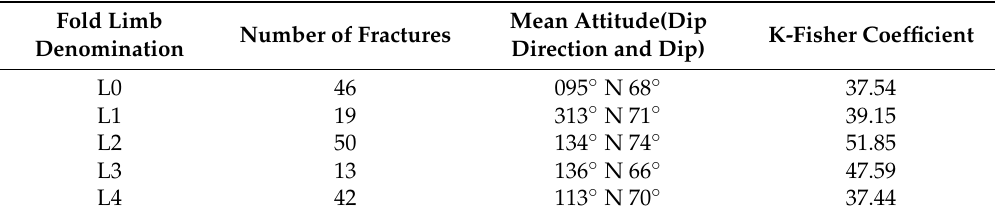
Table 12. Features of fracture set K5 determined in the different fold